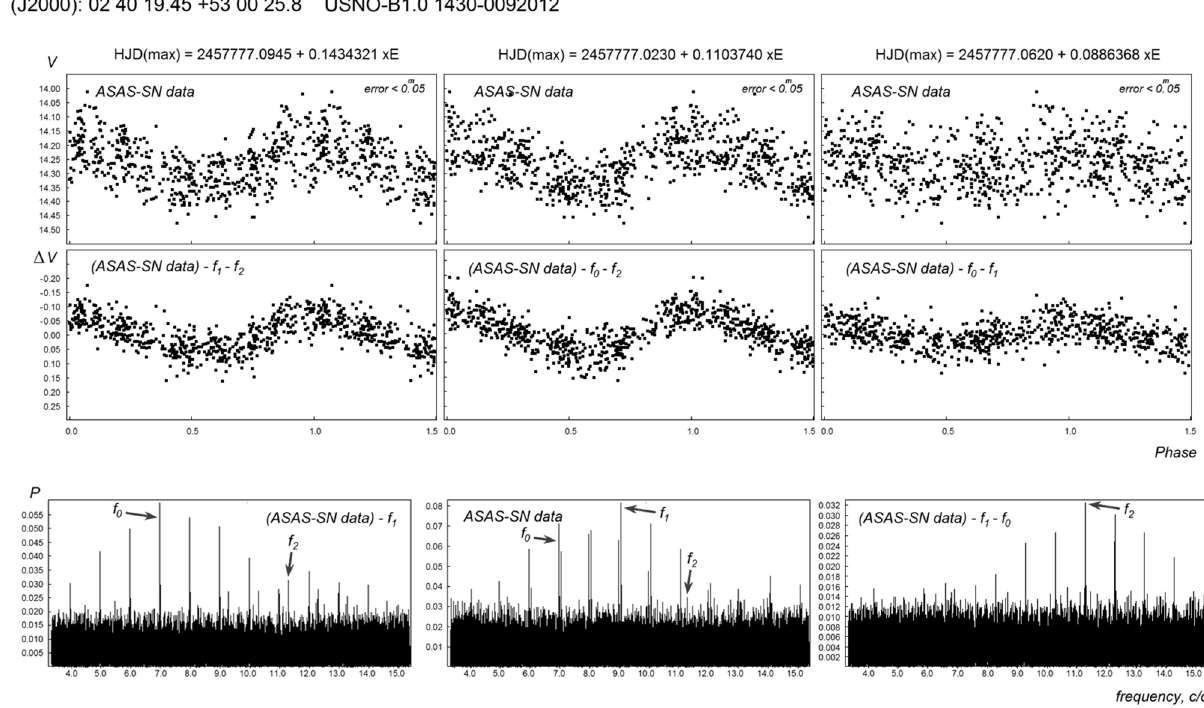
Figure 1: The light curves USNO - B1.0 1430 - 0092012 ( No. 1 ) .